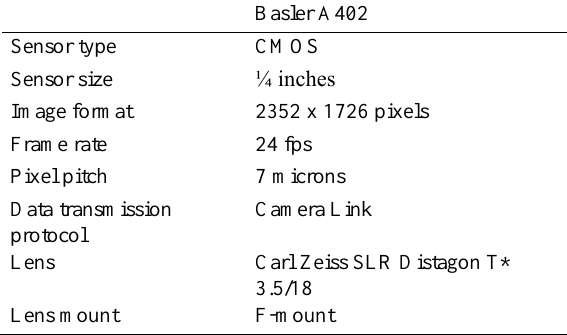
Table 1: Technical details of Basler A402 video camera